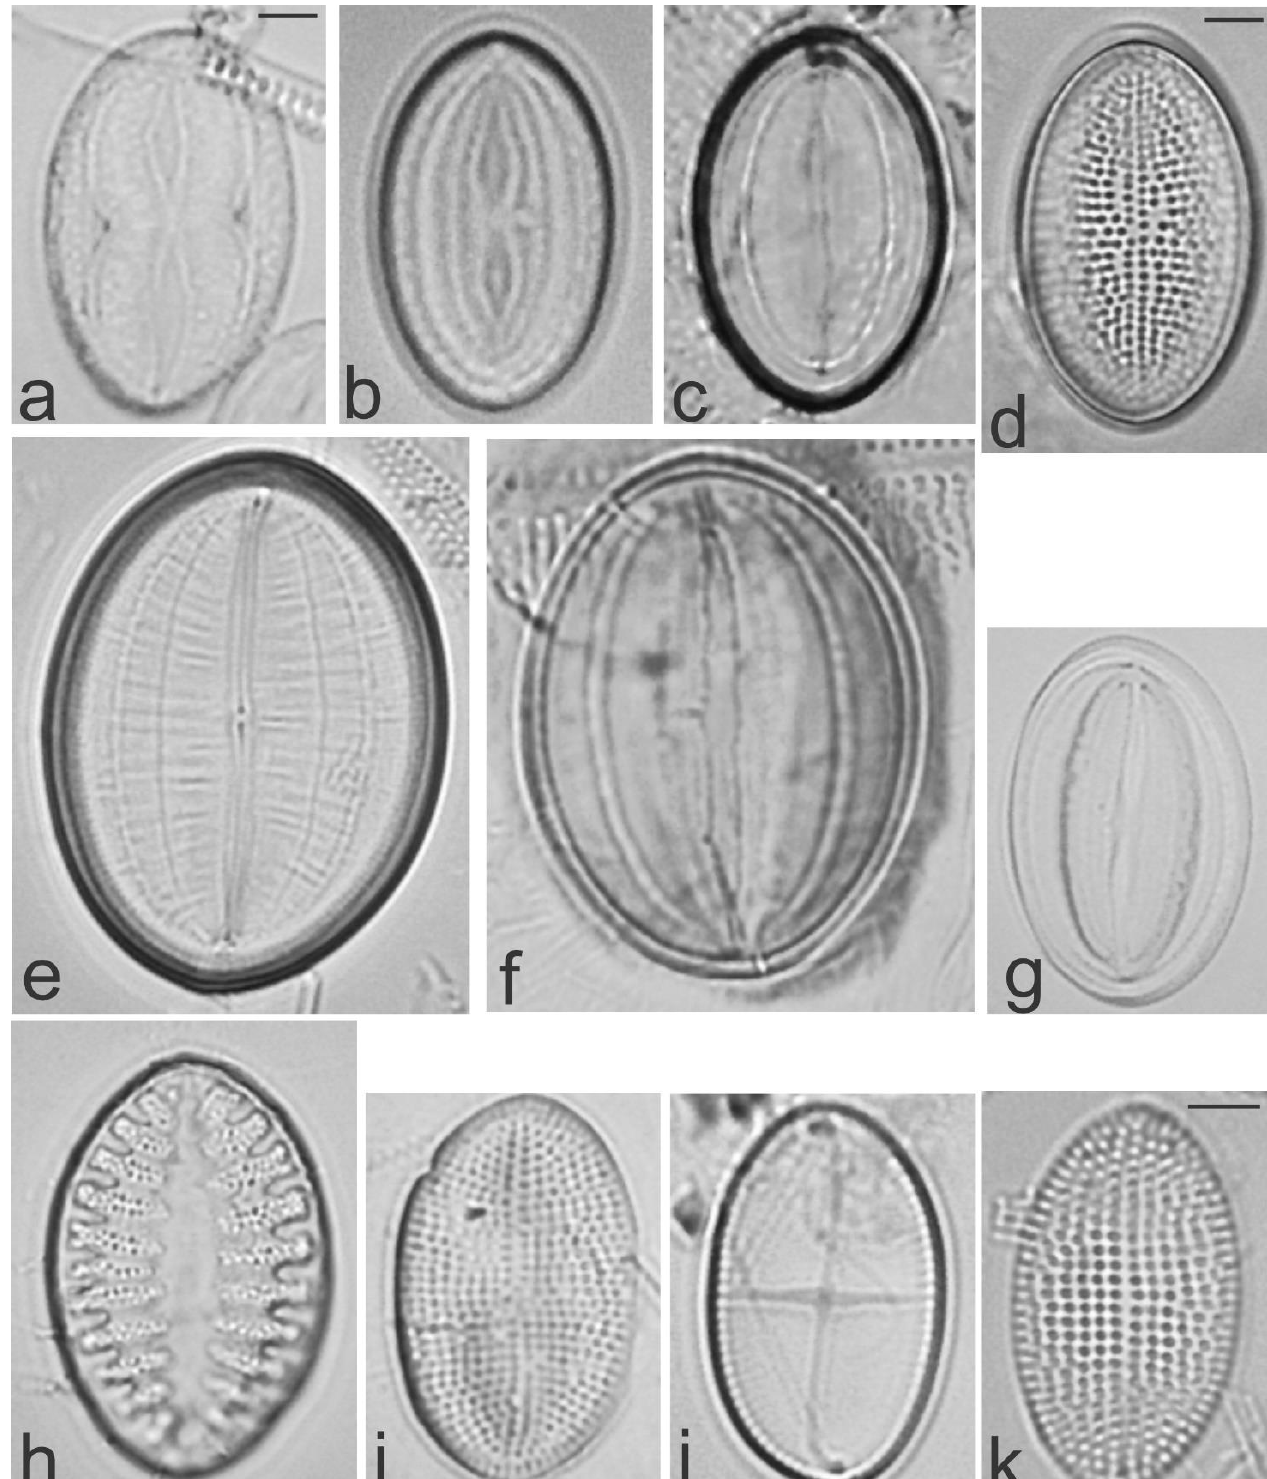
Figure 12. ( a ) Cocconeis caribensis ; ( b , c ) C. comis ; ( d ) C. hoffmannii ; ( e ) C. heteroidea ; ( f , g ) C. krammeri ; ( h ) C. pinnata ; ( i , j ) C. pseudodiruptoides ; ( k ) C. diruptoides. Scale bar = 5 μm.